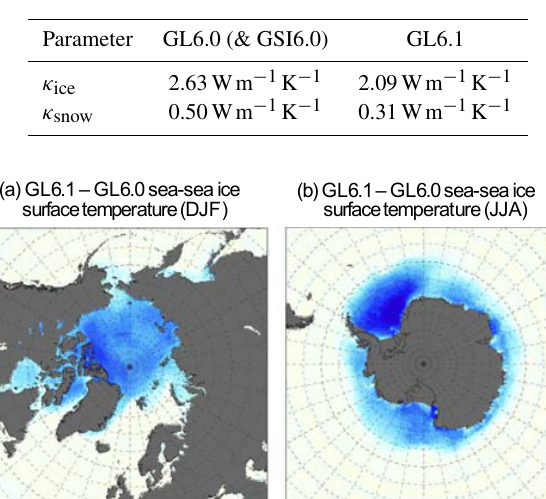
Table 4. Thermal conductivity of sea ice in GL6.0 and GL6.1.